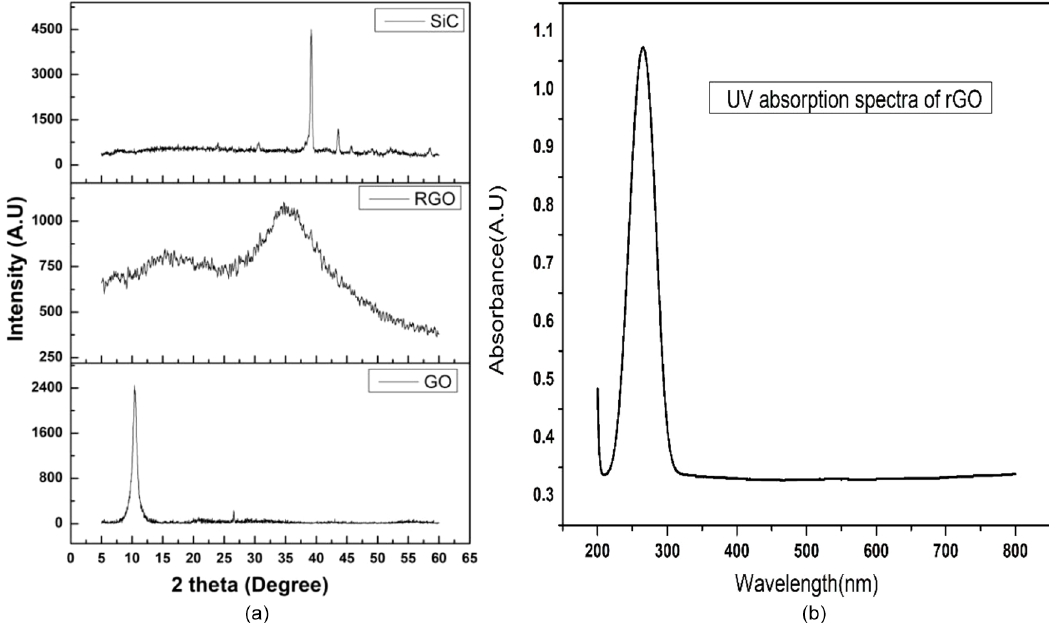
Fig. 1. (a) XRD patterns of GO, RGO, SiC and (b) UV – Vis spectrum of RGO.